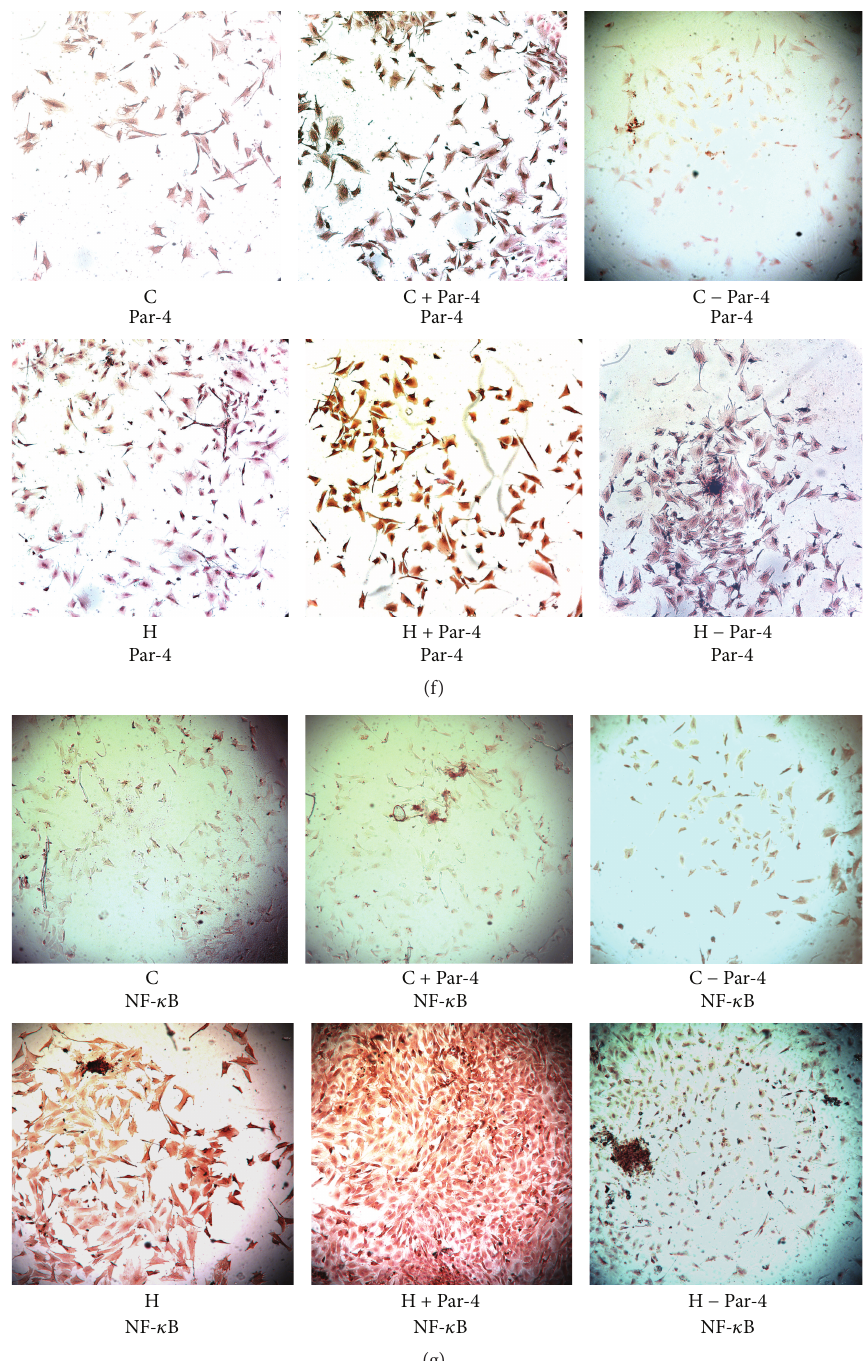
Figure 3: Glucose and palmitate cointervention activates Par-4/NF- 𝜅 B to induce